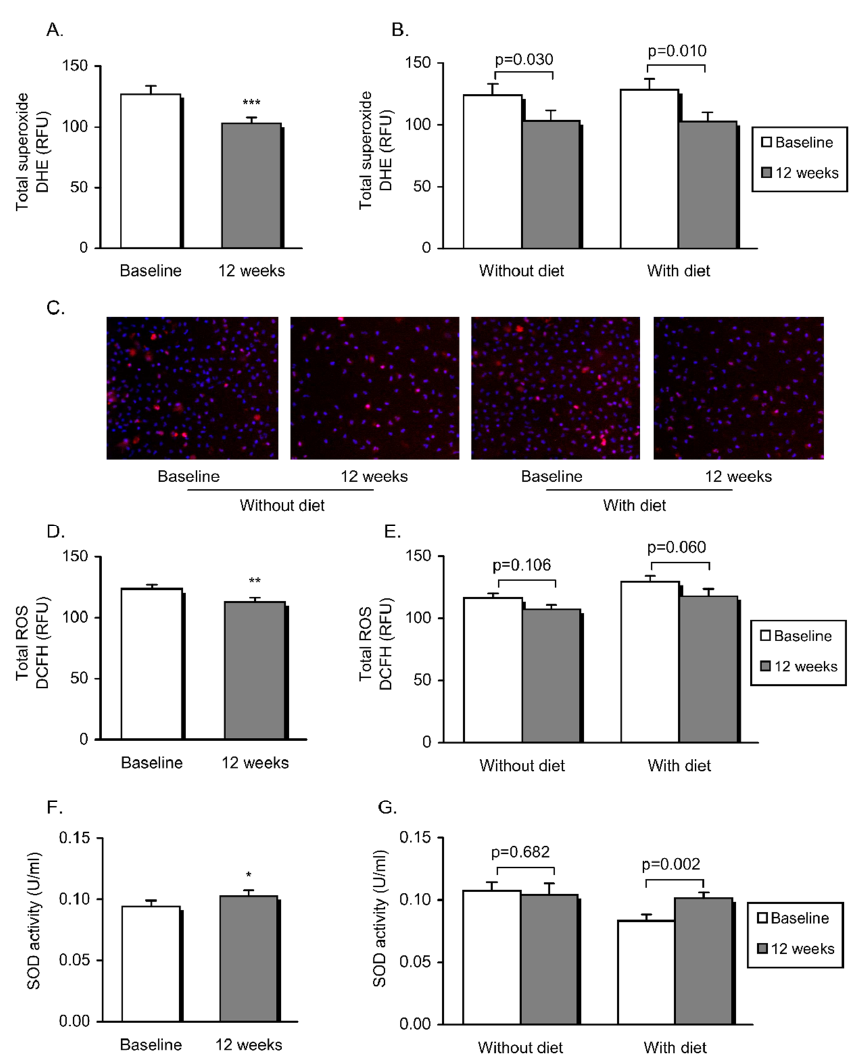
Figure 1. Parameters of oxidative stress in the study population before and after non-surgical periodontal treatment and dietary weight loss intervention. Total superoxide production was measured as arbitrary units of DHE fluorescence ( A , B ), and representative images depict DHE staining in red and Hoechst 33,342 nuclei fluorescence in blue ( C ). Total reactive oxygen species was calculated as the mean fluorescence intensity of DCFH ( D , E ). Superoxide dismutase activity in serum is also shown ( F , G ). Data are represented as mean + standard error. A paired Student’s t -test (* p < 0.05; ** p < 0.01; *** p < 0.001) was employed to compare the whole obese population before and after intervention. Obese patients undergoing vs. those not undergoing dietary therapy were compared before and after intervention using a paired Student’s t -test (differences were considered significant when p < 0.05).